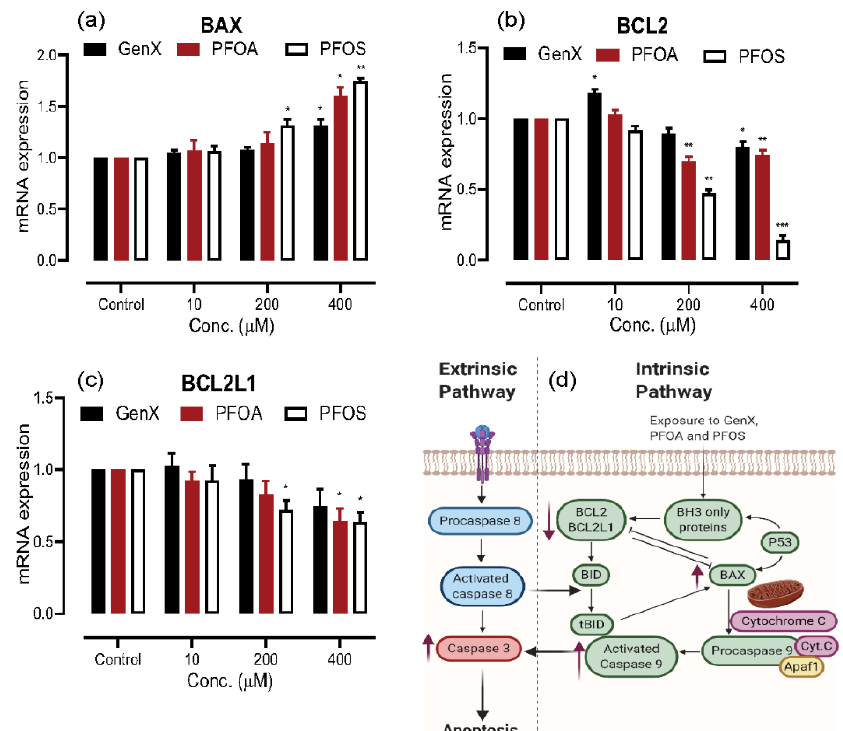
Figure 4. Determination of apoptosis induction in A549 cells upon exposure to GenX, PFOA and PFOS through quantitative real-time polymerase chain reaction (qRT-PCR). ( a ) Dose-dependent increase in mRNA expression levels of pro-apoptotic gene BAX, for all the compounds. ( b ) and ( c ) Dose-dependent decrease in the mRNA expression of anti-apoptotic genes BCL2 and BCL2L1, more significant with PFOS exposure. ( d ) The apoptosis pathway, red arrows indicate the change in expression in response to polyfluoroalkyl substances (PFAS)s. The data are given as the mean ± S.D. for three independent experiments (n = 3) (* = p < 0.05, ** = p < 0.005, *** = p < 0.001).